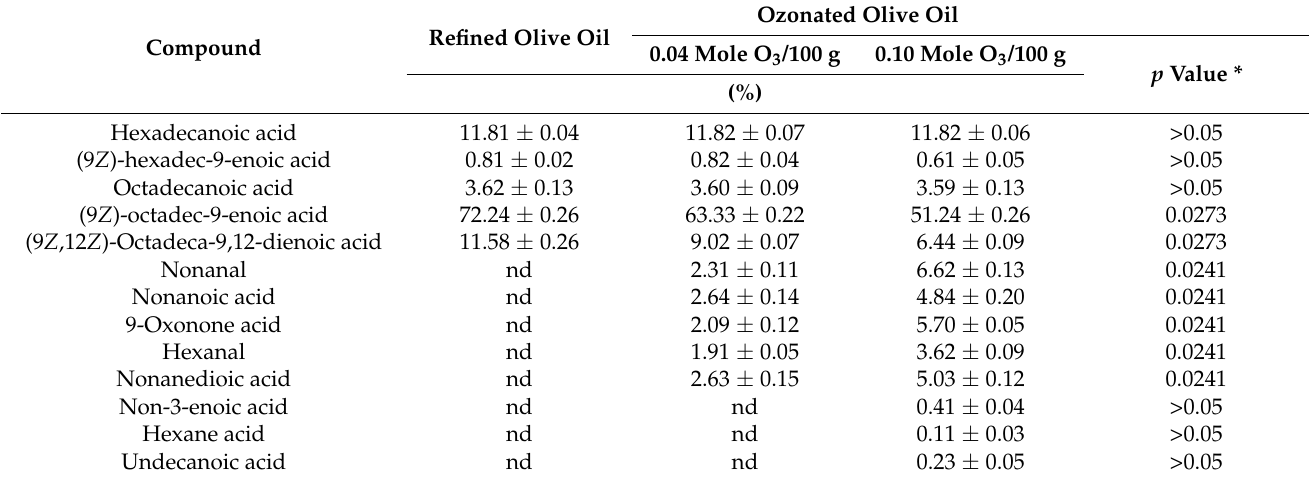
Table 1. The composition of refined and ozonated olive oils.